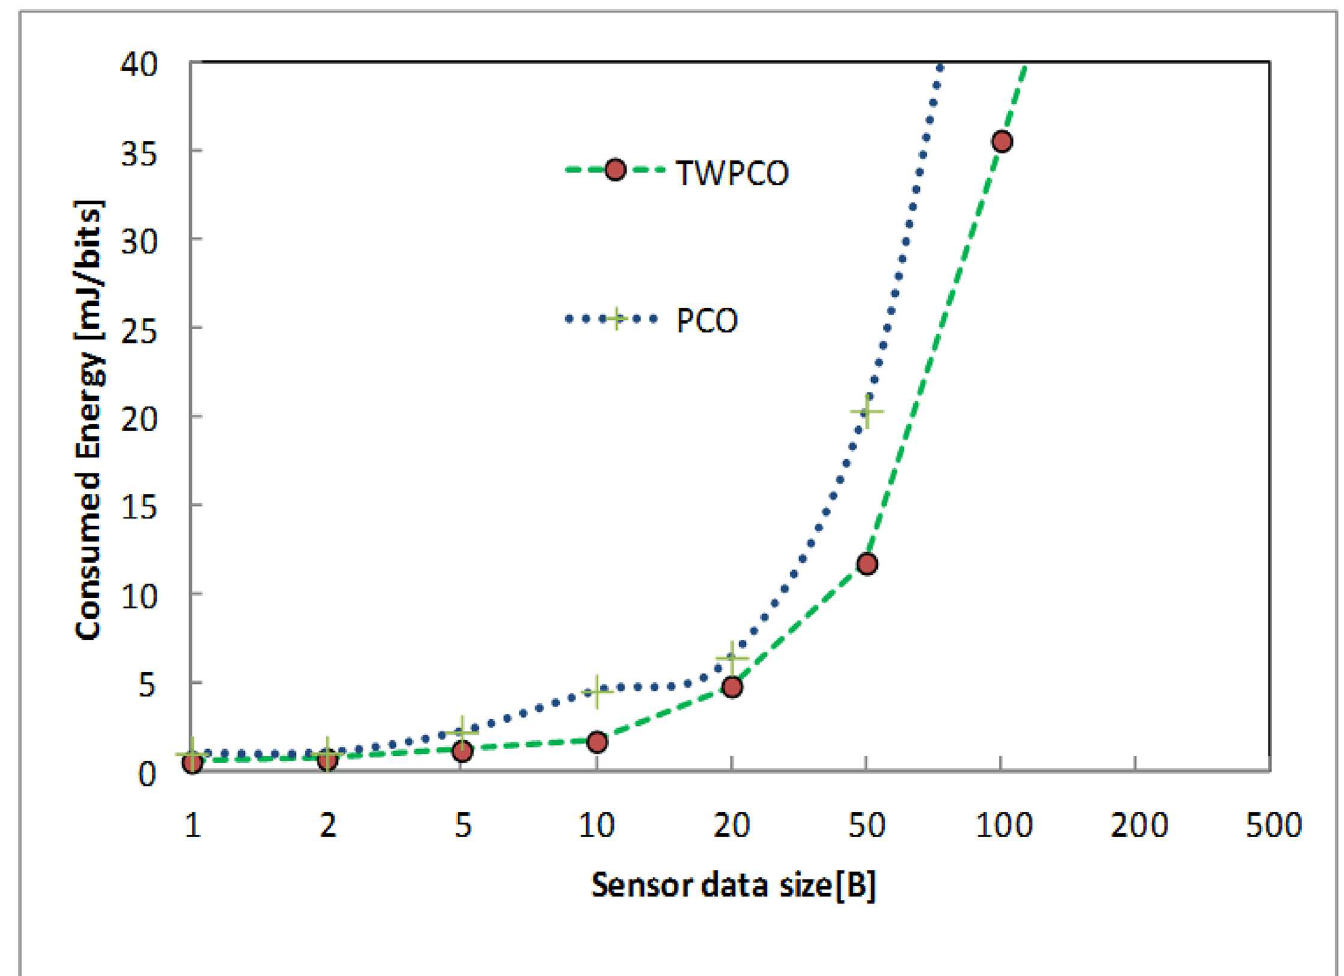
Fig 20. Energy efficiency ratio based on data size and added data